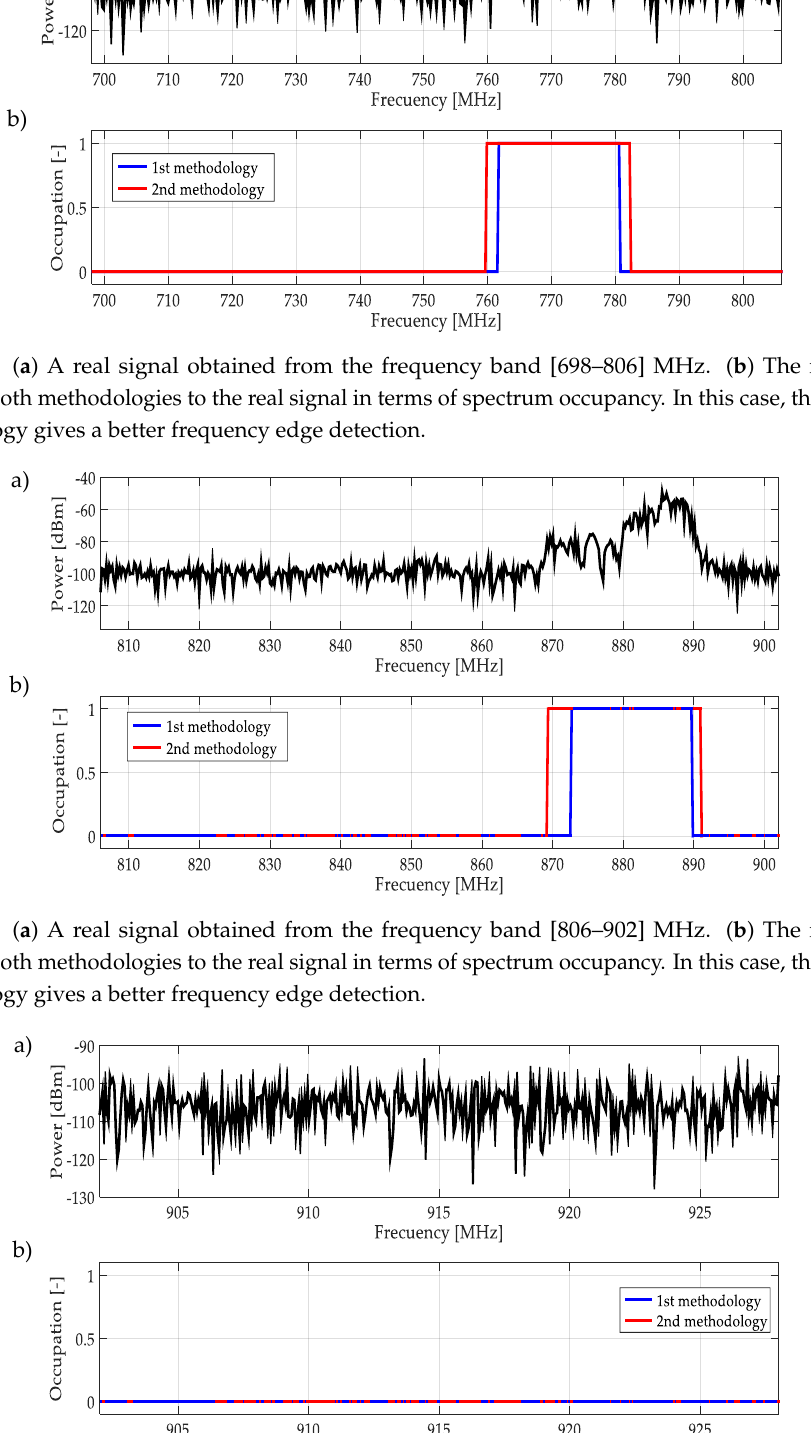
Figure 24. ( a ) A real signal obtained from the frequency band [1.7 – 2] GHz. ( b ) The result of applying both methodologies to the real signal in terms of spectrum occupancy. In this case, the second methodology gives a better frequency edge detection. Figure 25. ( a ) A real signal obtained from the frequency band [2.3 – 2.5] GHz. ( b ) The result of applying both methodologies to the real signal in terms of spectrum occupancy. In this case, the first methodology gives a better frequency edge detection.